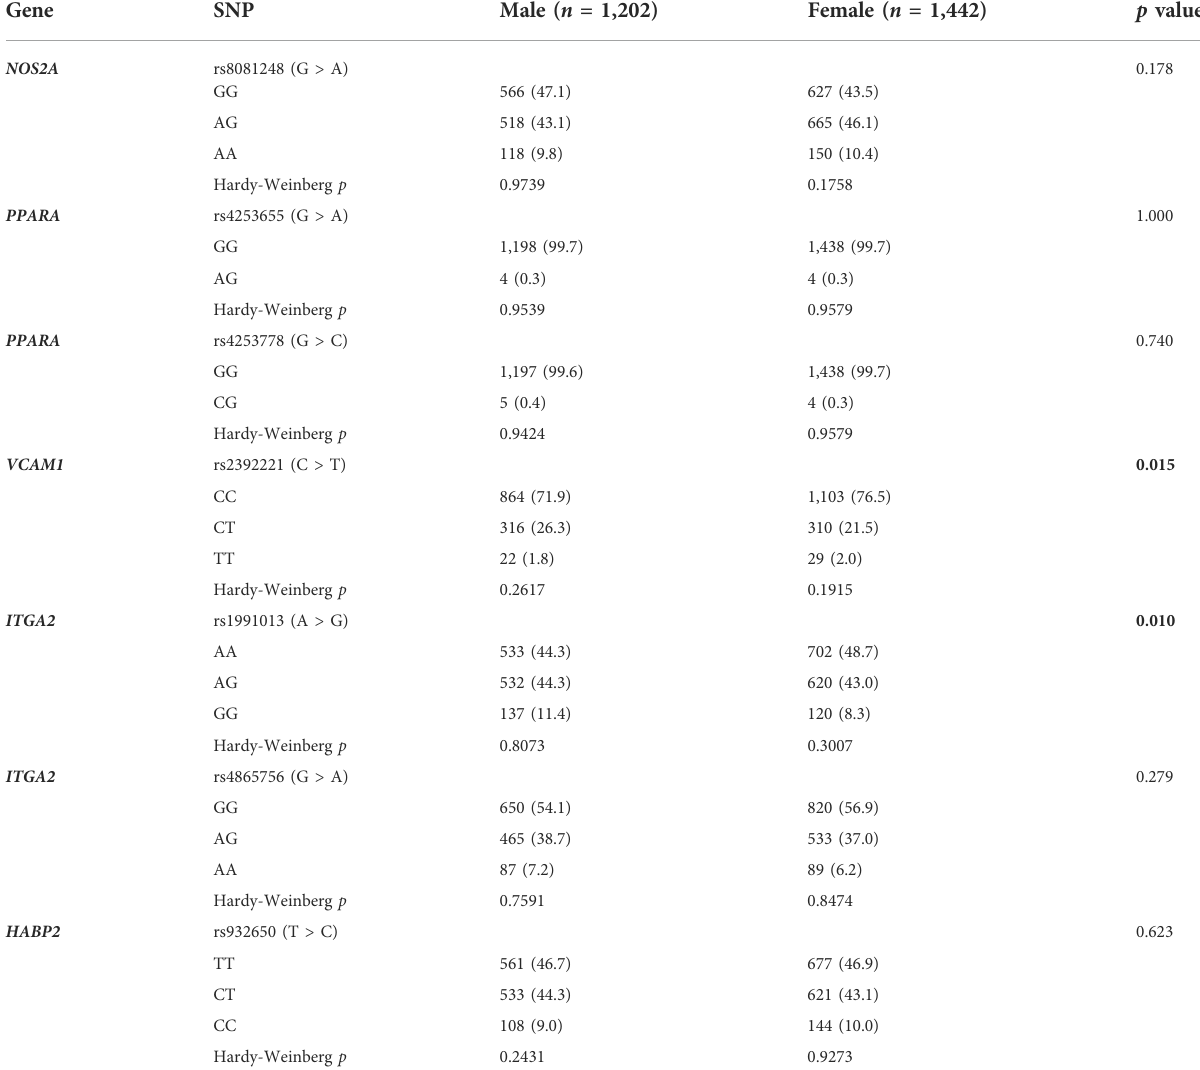
TABLE 1 ( Continued ) Genotype distributions of 17 SNPs in 10 genes between different